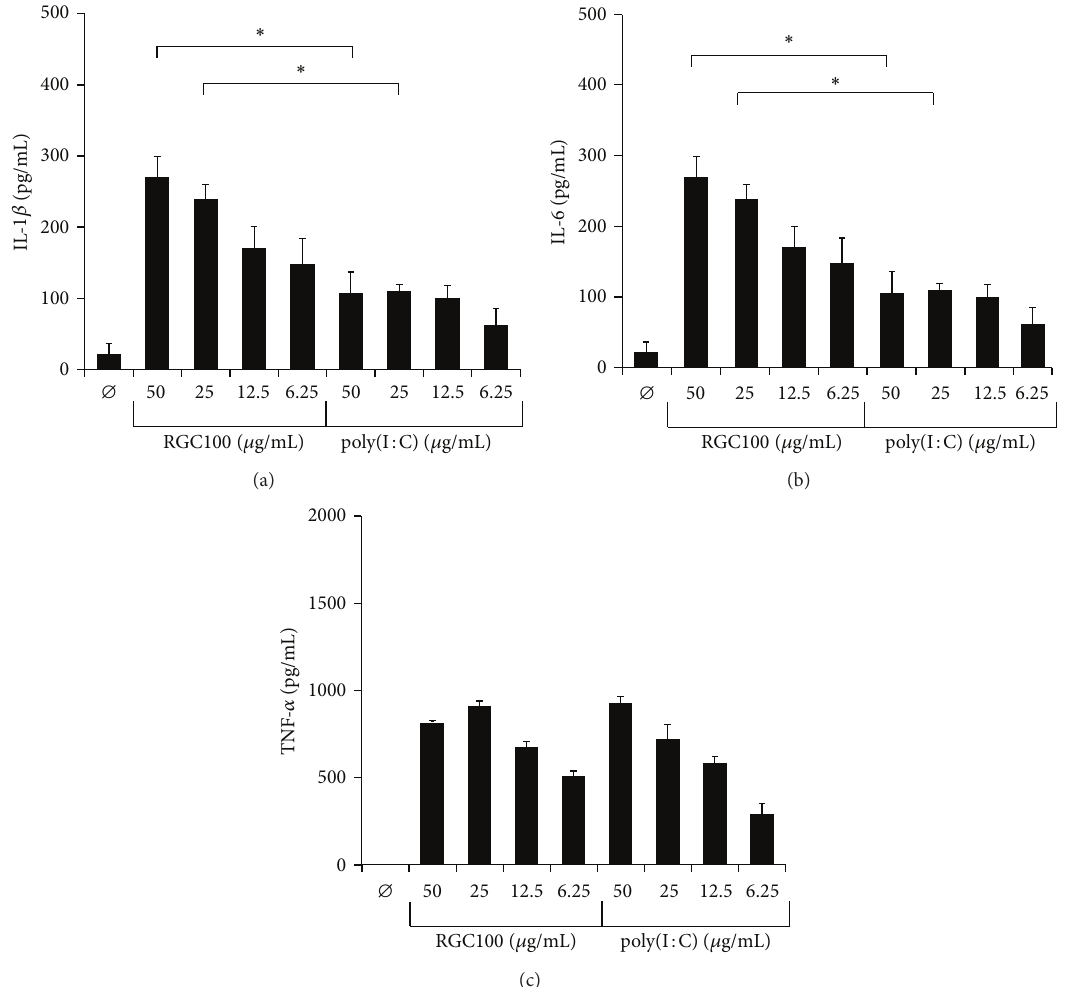
Figure 6: Activation of human myeloid CD1c + DCs by RGC100 and poly(I:C). Freshly isolated CD1c + DCs were cultivated in the presence or absence of RGC100 or poly(I:C). After 24 h, supernatants were harvested and the concentration of IL-1 𝛽 , IL-6, and TNF- 𝛼 was determined by ELISA as indicated. The results of one representative donor out of three performed with similar results are demonstrated. Values represent the mean ± SEM of triplicate samples and asterisks indicate a statistically significant difference ( 𝑃 < 0.05